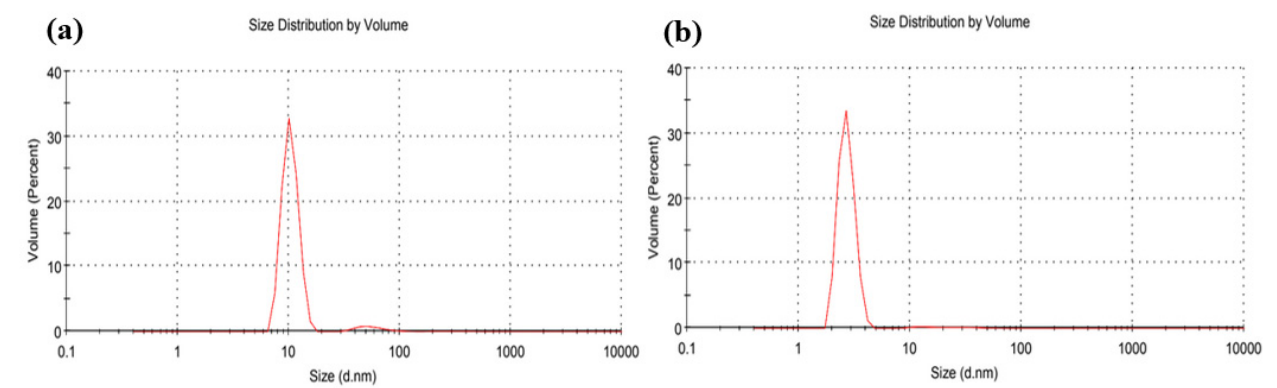
Figure 6. DLS size distribution of Ag NPs ( a ) without and ( b ) with simultaneous PLFL (120 min irradiation).